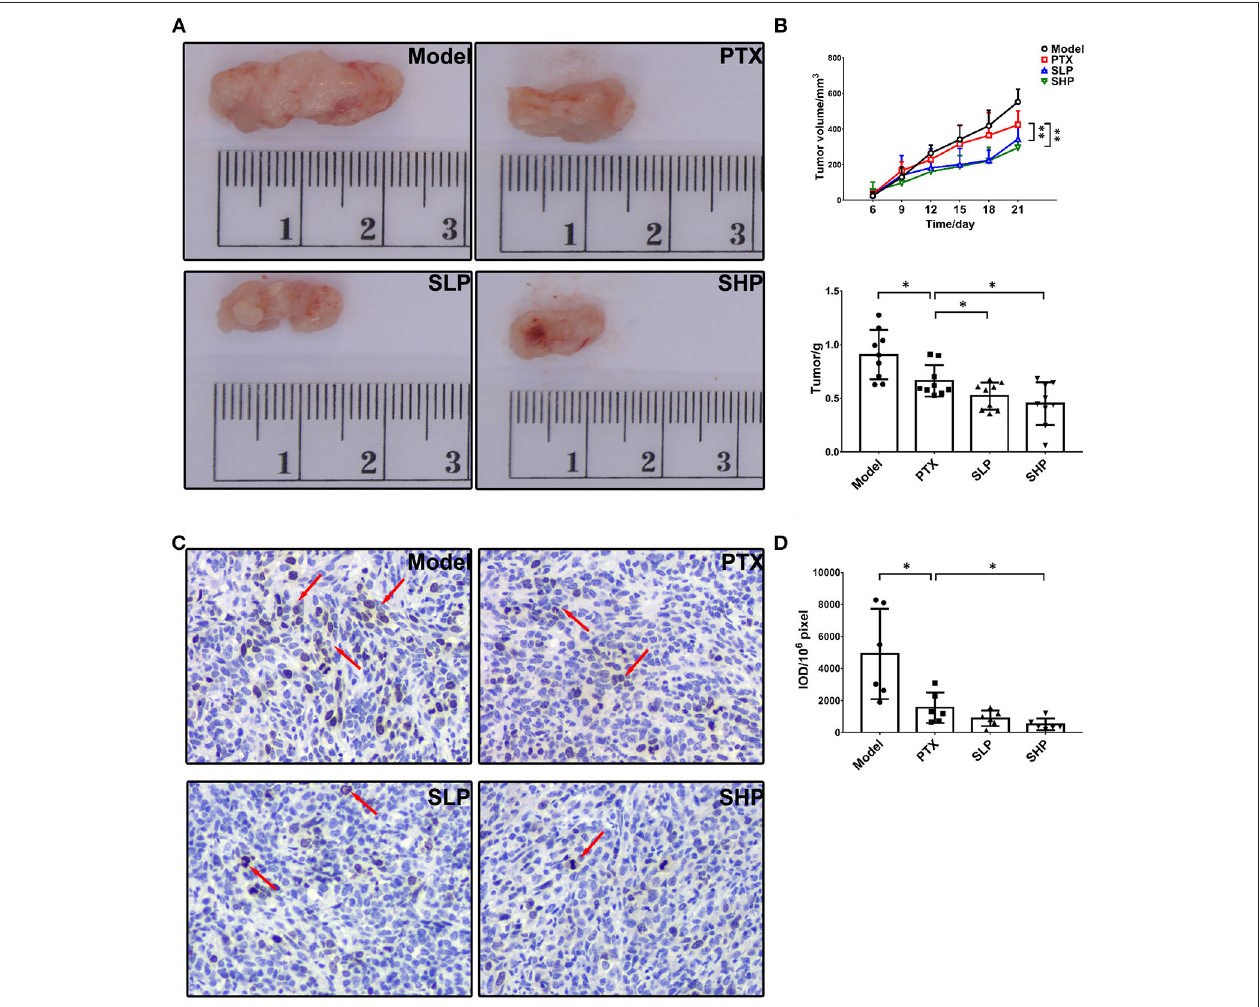
FIGURE 1 | Tumor growth observation. (A) Tumor volume ( n = 9). Tumor volume change between groups were compared by repeat measurement ANOVA. (B) Tumor mass ( n = 9). (C,D) Immunohistochemistry for ki67 in tumor and the representative image (200 × , n = 6). The mean density of positive area was calculated as ratio of integrated optical density to the total pixel of each picture (IOD/10 6 pixel). Values were represented the means ± SD. * p < 0.05 and ** p <